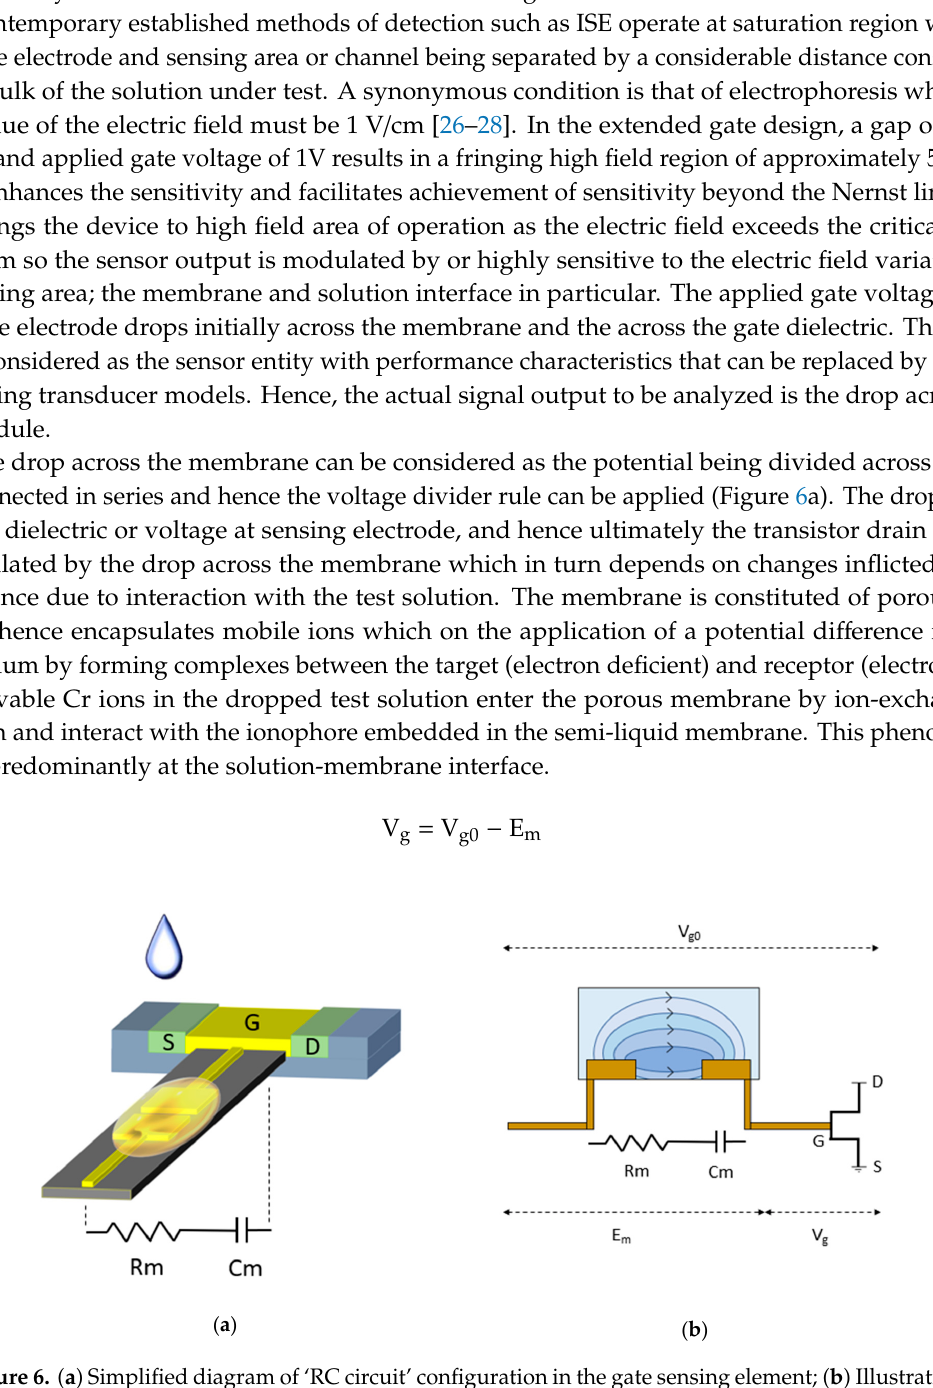
Figure 6. ( a ) Simplified diagram of ‘RC circuit’ configuration in the gate sensing element; ( b ) Illustrative representation of the sensing element and transducer with voltage dropped across series connection.